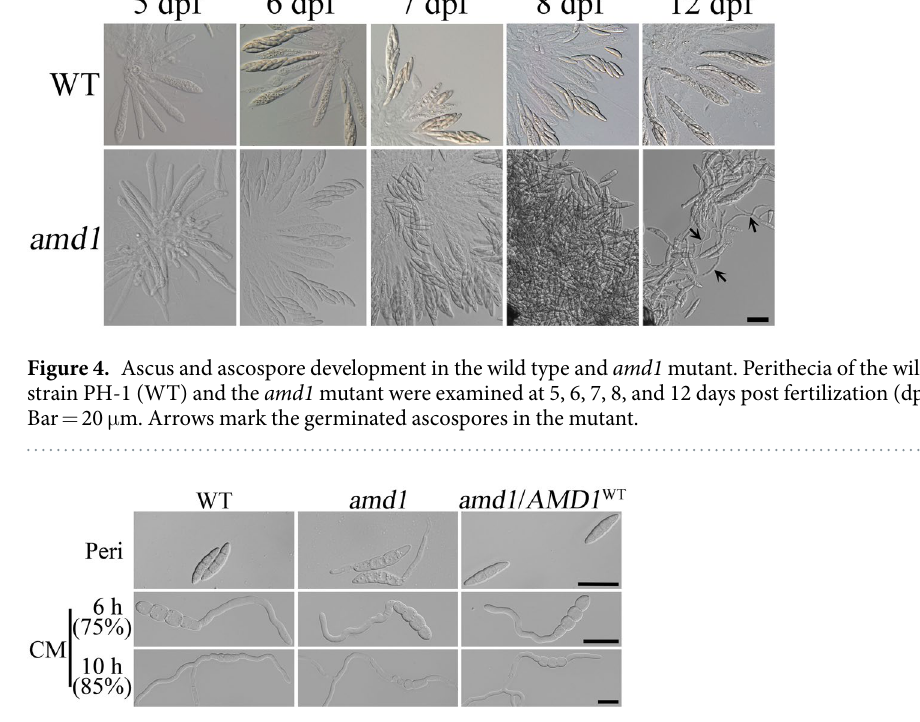
Figure 5. Germination of amd1 mutant ascospores in perithecia and CM cultures. Ascospores of the wild- type strain PH-1 (WT), amd1 mutant, and amd1/AMD1 WT -GFP complemented transformant amd1/AMD1 WT were examined for germination in 12 dpf perithecia (Peri) or after incubation in complete medium (CM) at 25 °C for 6 h and 10 h. Ascospore germination was not observed in the wild type but germination from one end of ascospores was observed in the amd1 mutant. When incubated in CM, germination from both ends of ascospores increased from approximately 25% at 6 h to 85% at 10 h in both the wild type and amd1 mutant. Bar = 20 μ m.